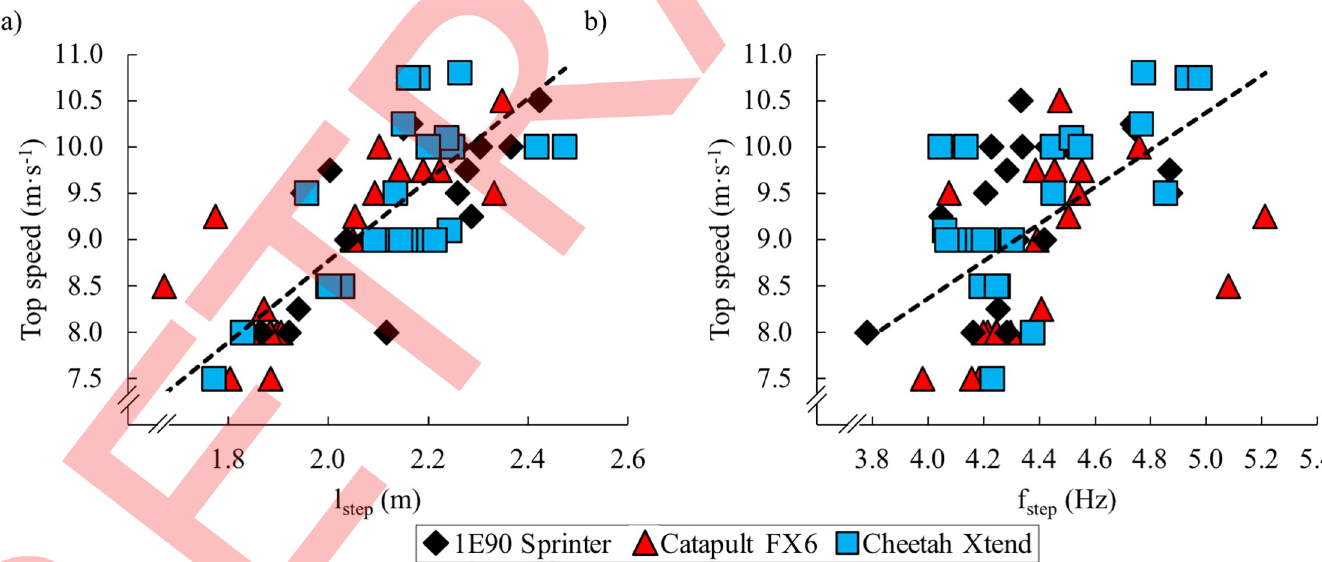
Fig 4. Maximum speed as a function of: a) step length (l step ) and b) step frequency (f step ). Each data point represents a single subject and RSP model. The dashed line is the regression line obtained from Eq 2: Maximum speed (m � s − 1 ) = 3.80 × l step +1.24 (R 2 = 0.843, p < 0.001) and Eq 3: Maximum speed (m � s − 1 ) = 1.27 × f step +3.59 (R 2 = 0.463, p =